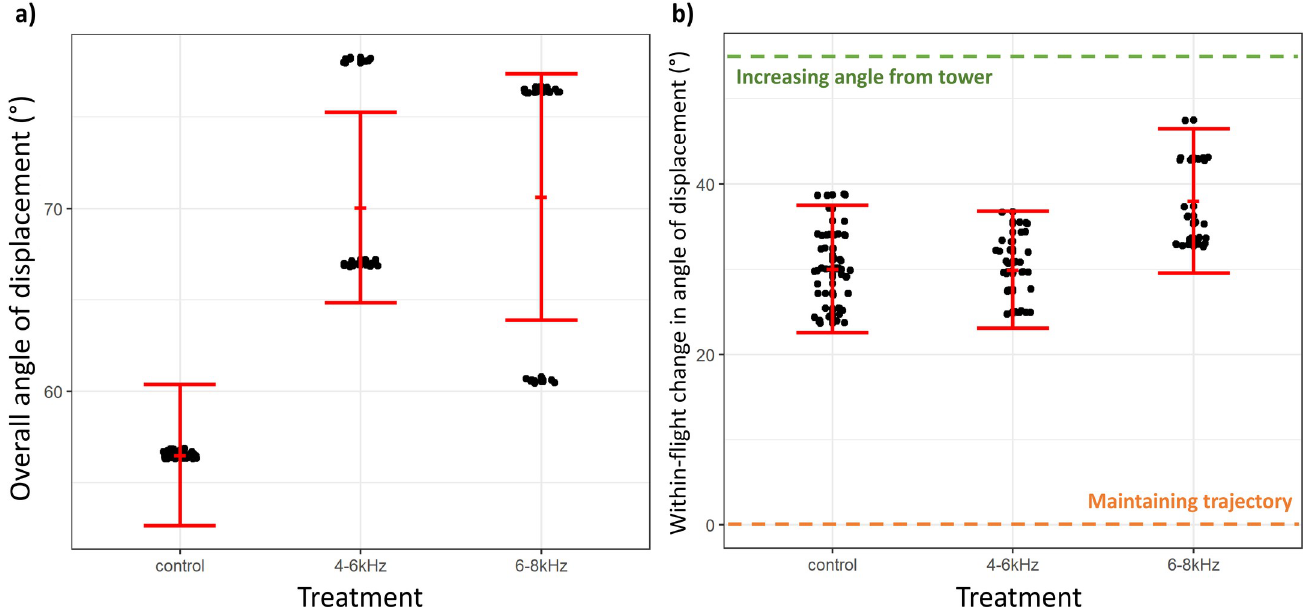
Fig 5. Angle of displacement by treatment condition. Panel a) shows the overall angle of displacement by treatment condition. Panel b) shows the within-flight change in angle of displacement by treatment condition. Solid red dots and error bars represent model-averaged mean of outcome variable ± standard error of the mean. In panel b), the green dotted line indicates an increasing angle of displacement from towers and the orange dotted line indicates a maintenance of trajectory towards towers.